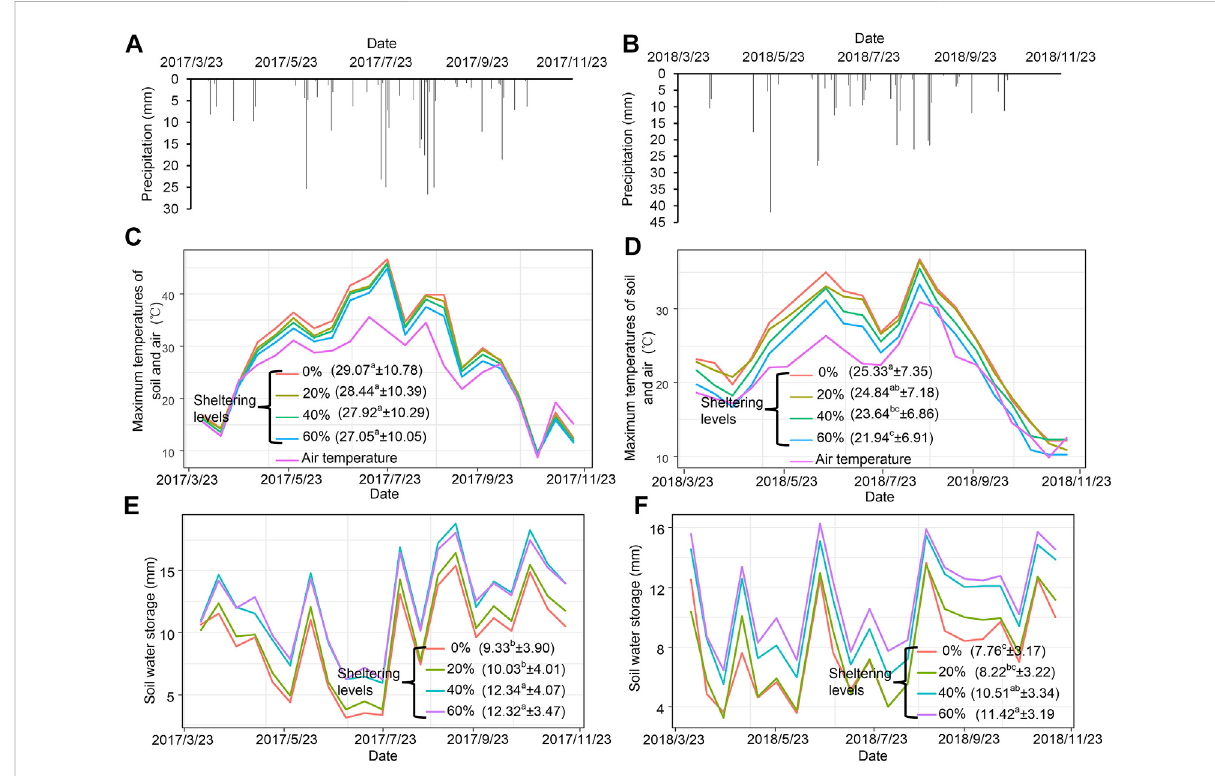
FIGURE 2 The precipitation (A,B) over the two growing seasons, and the maximum soil temperatures (C,D) and soil water storages (E,F) of degraded grassland under different branch sheltering levels in 2017 and 2018. Data in parentheses were average soil temperature ±SE (C,D) and average soil water storage ±SE (E,F) , and different letters indicate signi fi cant differences among different treatments at the 0.05